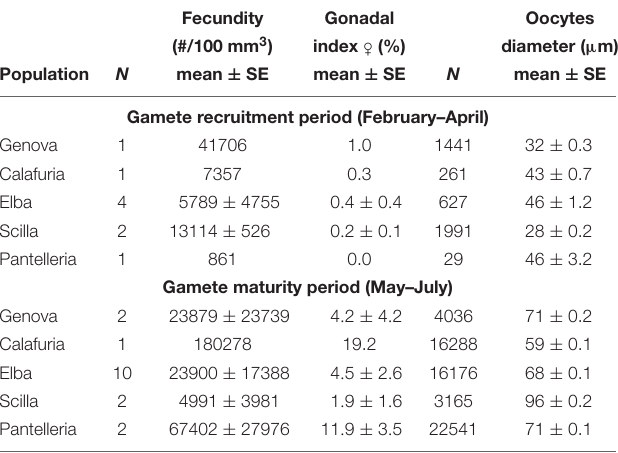
TABLE 5 | Mean fertility of females (F), males (M) and inactive individuals (I) in each population for gamete recruitment and gamete maturity periods. Fertility F Fertility M Fertility I